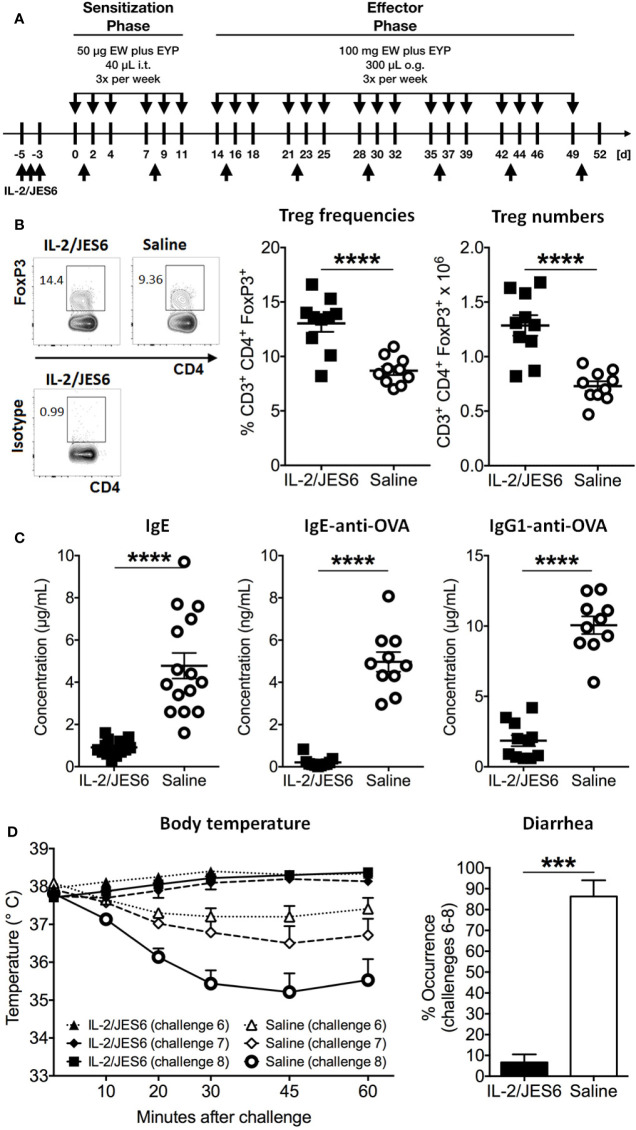
Prophylactic IL-2/JES6 treatment. (A) Experimental scheme. Mice were treated with IL 2/JES6 or saline (up-arrows) and sensitized by i.t. inoculations with egg white (EW) plus egg yolk plasma (EYP), as indicated (down-arrows). Later, mice were repeatedly challenged with EW plus EYP. (B) CD3+ CD4+ FoxP3+ Treg populations in spleen after the 12th challenge, analyzed by flow cytometry. (C) Total serum IgE, ovalbumin (OVA)-specific IgE and IgG1 after six i.t. sensitizations, as assessed by ELISA. (D) Rectal temperature curve (left) and diarrhea development (right) after oral antigen challenges six to eight. Data shown from one of two independent experiments (n = 14 15). Data depicted represent mean ± SEM. ***p < 0.001, ****p < 0.0001 (Student’s t-test).